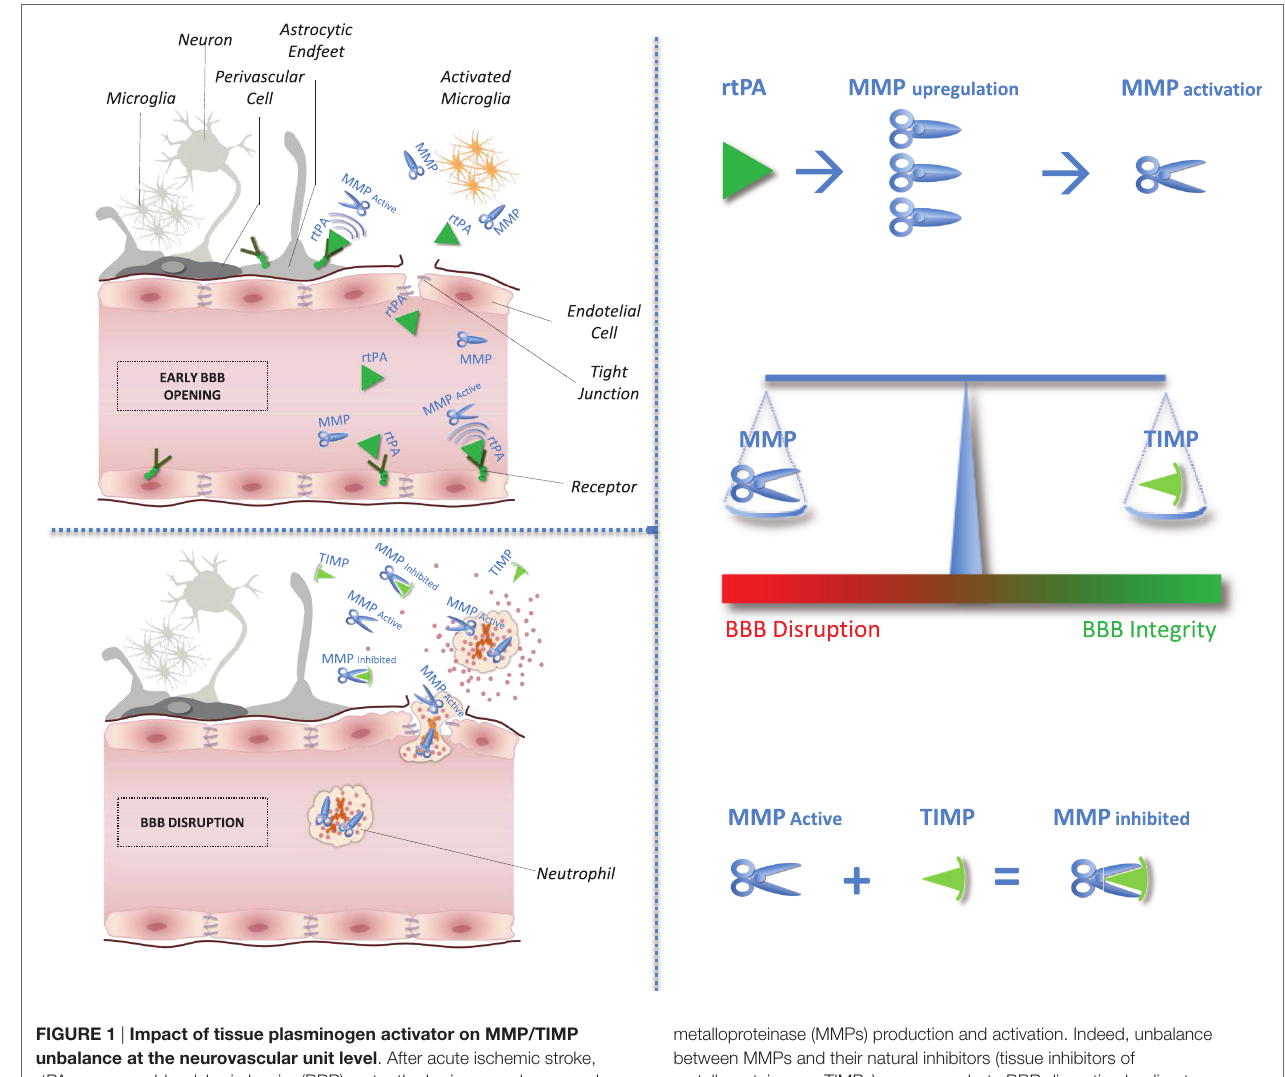
FigUre 1 | impact of tissue plasminogen activator on MMP/TiMP unbalance at the neurovascular unit level . After acute ischemic stroke, rtPA may cross blood–brain barrier (BBB), enter the brain parenchyma, and thereby damage neurovascular unit components by